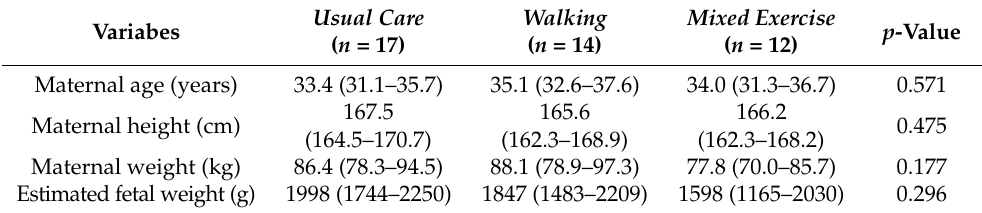
Table 4. Anthropometric and baseline characteristics * during the first antenatal visit. Variabes